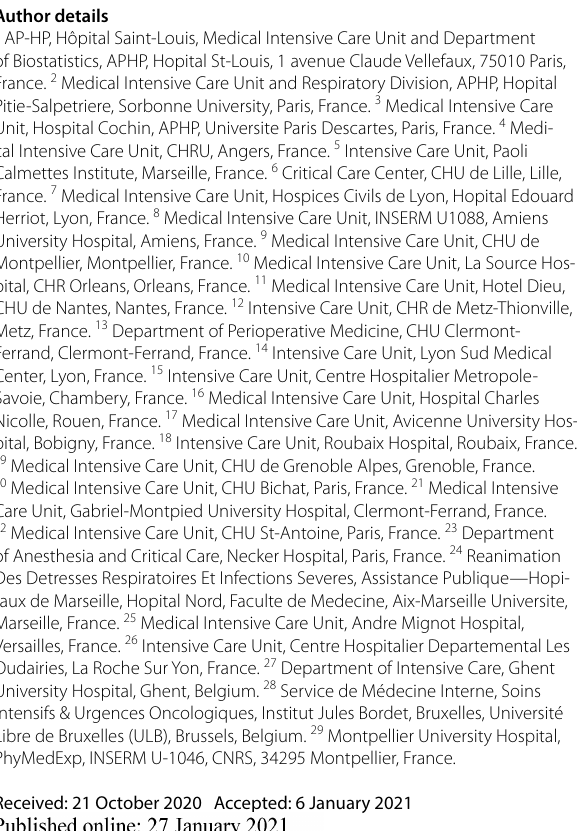
Table 3 Adjusted ROX index 6 h after HFNC